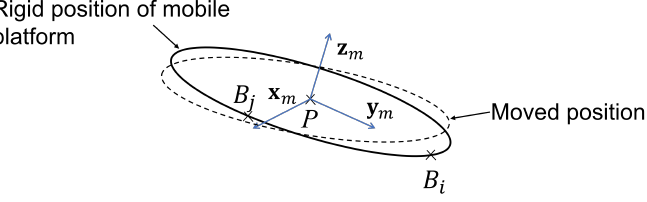
Figure 5. Parametrization of mobile platform small